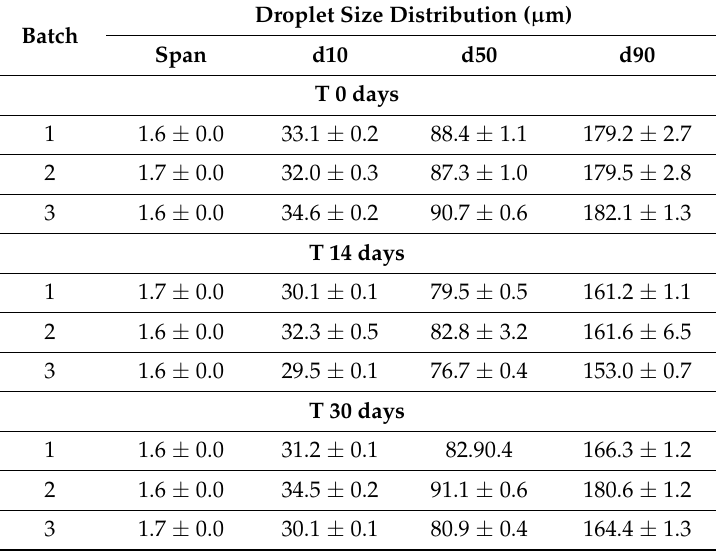
Table 4. Droplet size distribution of QSB-based emulsion.